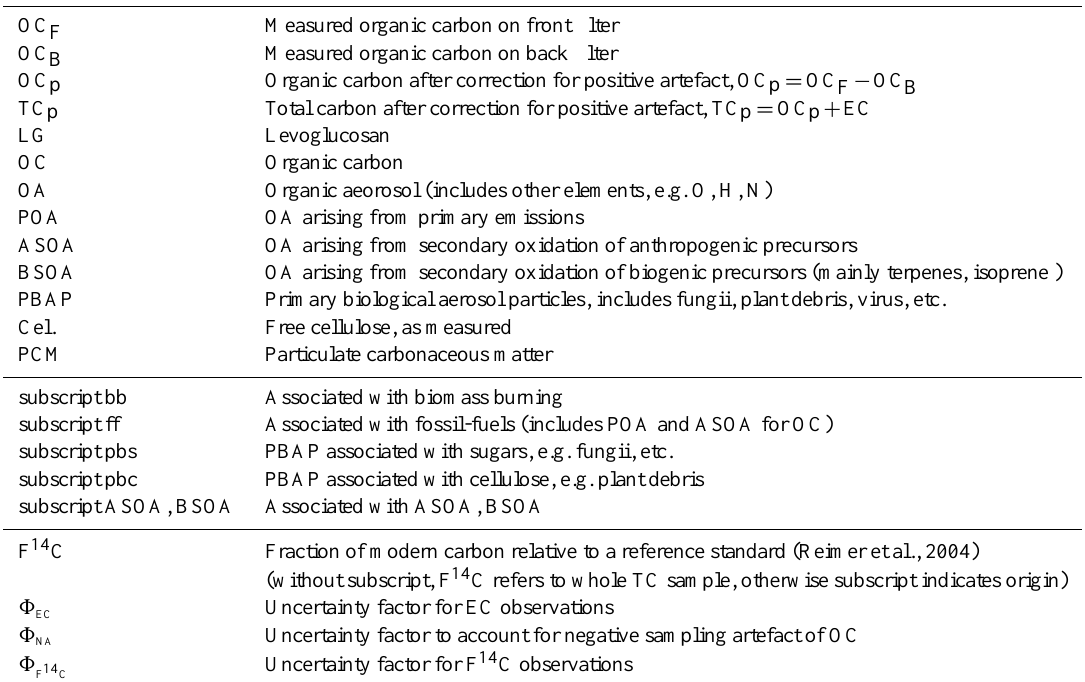
Table 1. Notation used in this